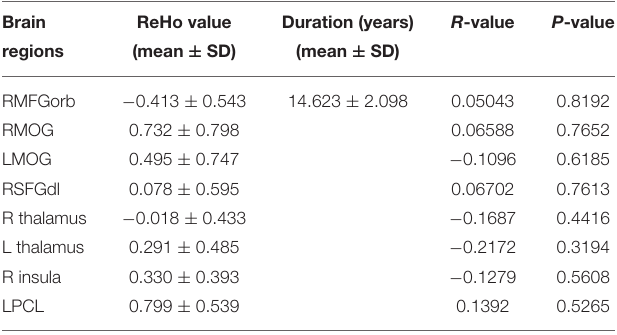
TABLE 4 | Pearson correlation analysis between the ReHo values in the altered brain areas and the duration of blindness.